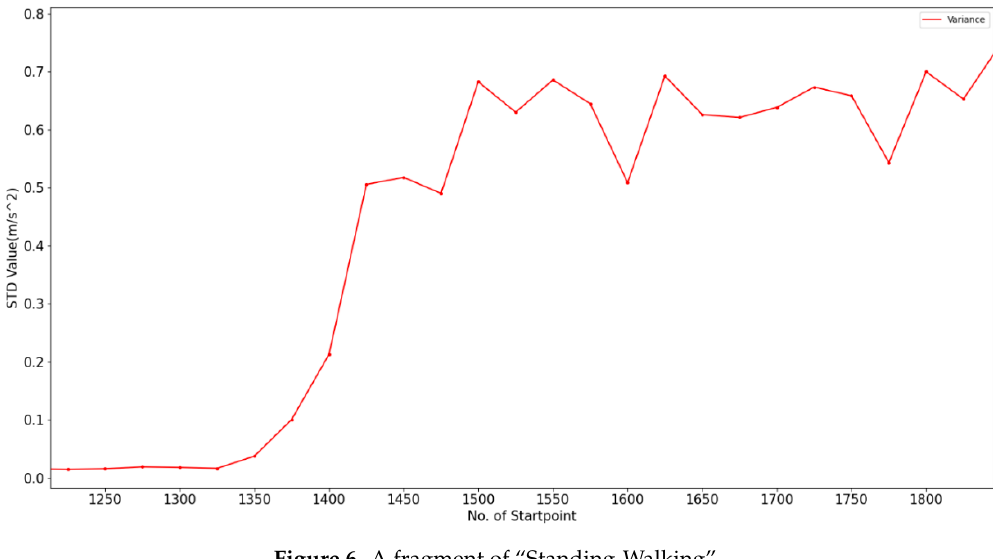
Figure 6. A fragment of “Standing-Walking”.